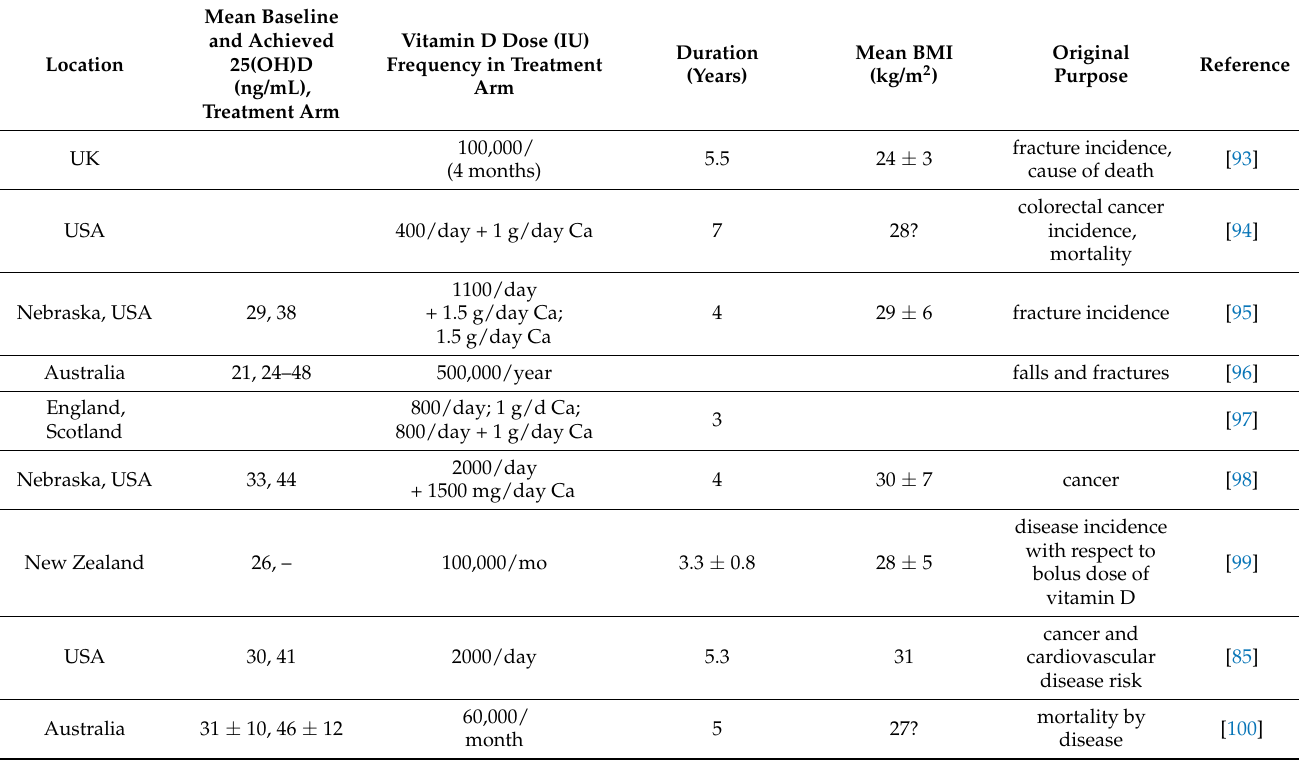
Table 8. Characteristics of ten RCTs that investigated the effect of vitamin D supplementation on risk of cancer incidence and/or mortality rate.